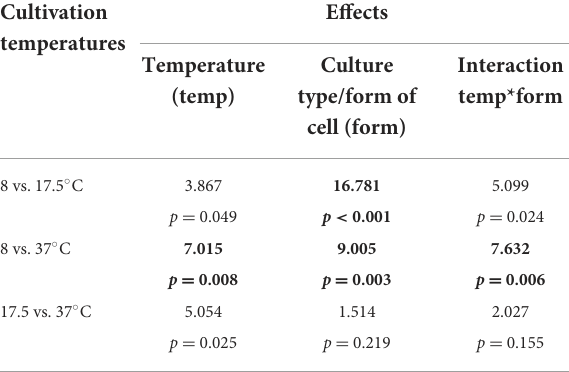
TABLE 1 Influence of cultivation temperature (8, 17.5, and 37 ◦ C) and culture type/form of cells (adherent vs. in-suspension cells) on cell proliferation pattern in Experiment 1 during 6 cultivation